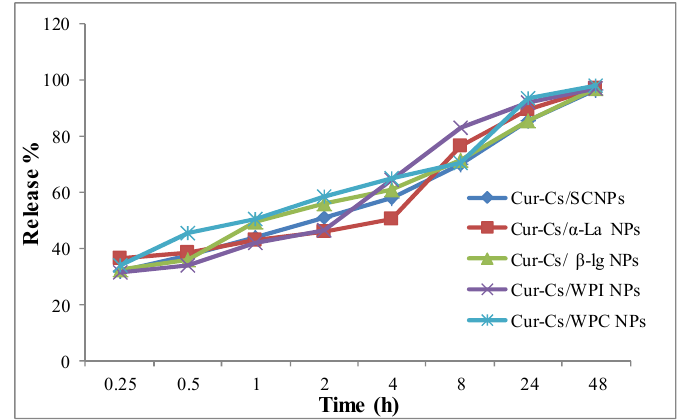
Figure 3. In vitro release profiles of curcumin from curcumin–milk protein nanoparticles.